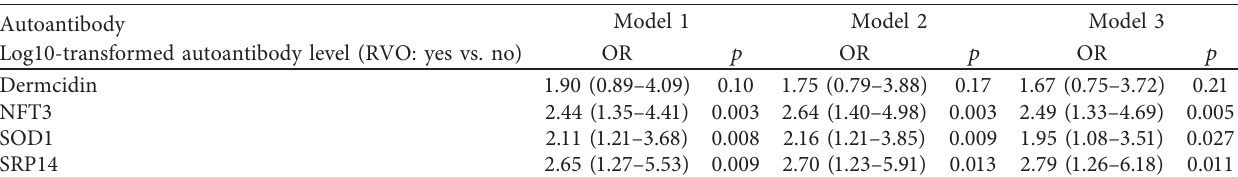
Results arefromconditional logisticregression analysis. Model 1 isadjusted for batch,model2 is adjusted forage, sex,and cardiovascularrisk factors(obesity, arterial hypertension, diabetes mellitus, smoking, dyslipidemia, family history of myocardial infarction or stroke, and batch), and model 3 is adjusted for age, sex, and cardiovascular risk factors (BMI, mean arterial blood pressure, HbA1c, HDL, LDL, triglycerides, smoking, family history of myocardial infarction or stroke, and batch). OR is the per log10-transformed autoantibody level.